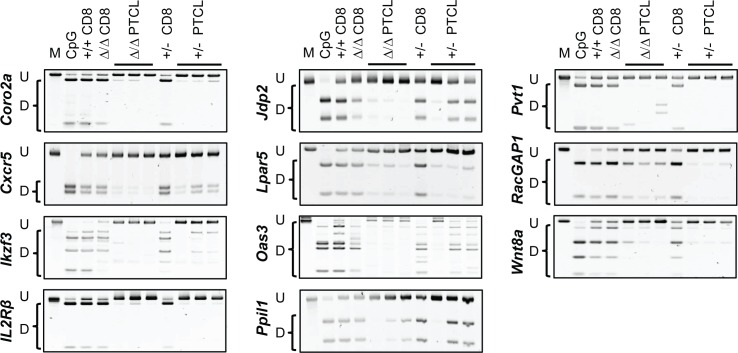
Promoter hypomethylation is conserved across multiple Dnmt3aΔ/Δ and Dnmt3a+/- mouse lymphomas.COBRA analysis of promoter methylation for Coro2a, Cxcr5, Ikzf3, IL2Rβ, Jdp2, Lpar5, Oas3, Ppil1, Pvt1, Racgap1 and Wnt8a in wild-type CD8+, Dnmt3aΔ/Δ pre-tumor CD8+, Dnmt3aΔ/Δ PTCL, Dnmt3a+/- pre-tumor CD8+, and Dnmt3a+/- PTCL samples. PCR fragments amplified from bisulfite-treated genomic DNA were digested with the restriction enzymes BstUI, Taq1 or TaiI. Undigested (U) and digested (D) fragments correspond to unmethylated and methylated DNA, respectively. Control PCR fragments generated from fully methylated mouse genomic DNA that is undigested (M) or digested (CpG) are shown.